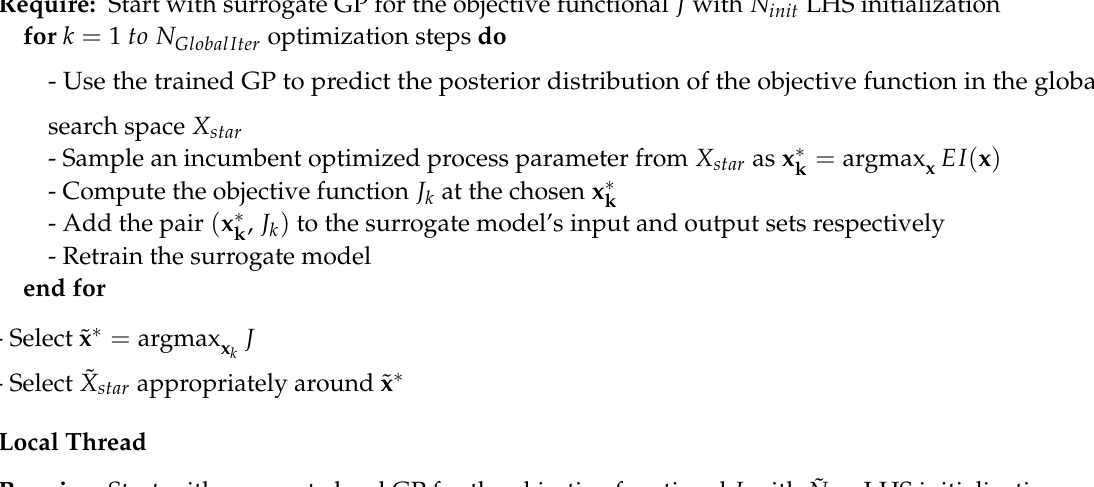
Algorithm A1 Optimization Routine Global